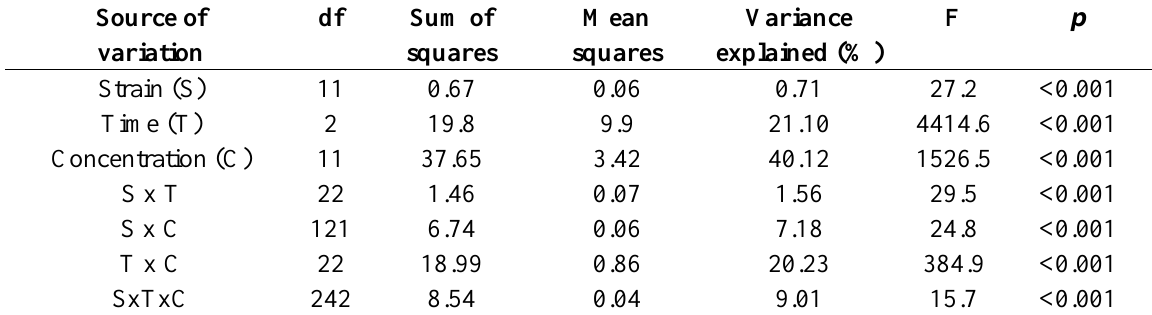
Table 4. Multivariate analysis of variance by three-way ANOVA of S. aureus